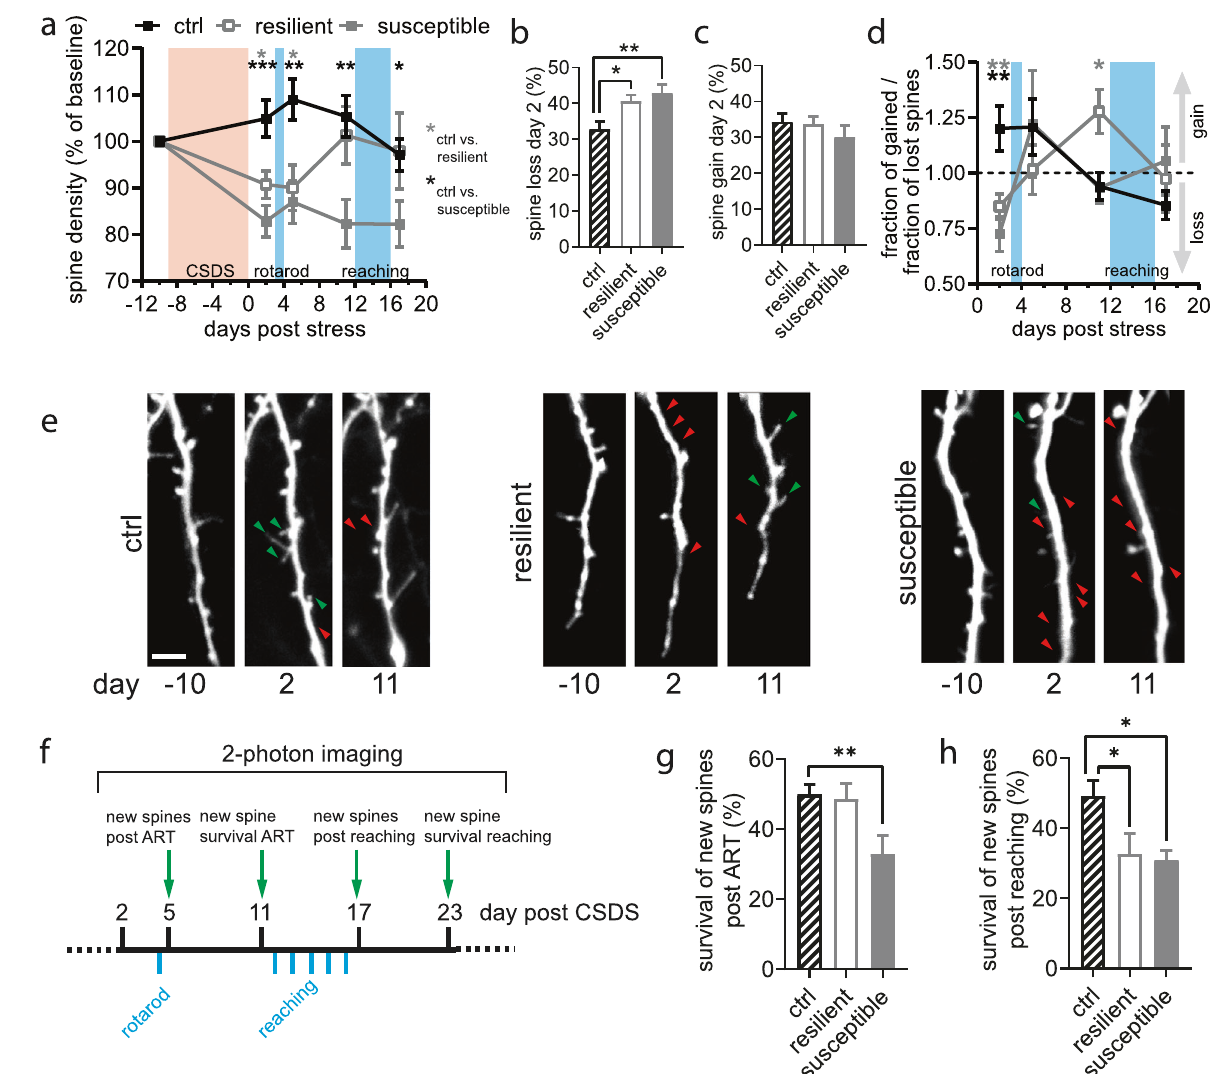
Fig. 3 Response and recovery of motor cortical spine dynamics after CSDS. a Development of spine density from day 2 until 17 post CSDS (time F 3.155,163.3 = 3.425, P = 0.017, stress F 2,64 = 8.324, P = 0.0006, Interaction F 8,207 = 4.211, P = 0.0001, RM ANOVA mixed model with Dunett ’ s post-hoc test). b , c Change in spine loss but not spine gain drives the change in spine density on day 2 (loss: F 2,64 = 6.784, P = 0.002, one-way ANOVA with Dunett ’ s post-hoc test, gain: F 2,64 = 0.767, P = 0.487, one-way ANOVA). d Net gain or loss between imaging sessions is differently in fl uenced by stress over time (time F 2.303,109.8 = 2.221, P ≥ 0.05, stress F 2,51 = 0.347, P ≥ 0.05, interaction F 6,143 = 3.164, P ≤ 0.01, RM ANOVA mixed model). e Example time lapse images of dendritic spines at baseline (day − 10), day 2 and 11 post CSDS (green arrowhead = new spine, red arrowhead = lost spine). Scale bar: 5 µm). f , g Survival fraction of spines formed after the different motor learning tasks (rotarod [ART]: F 2,48 = 4.918, P = 0.011, reaching: F 2,31 = 4.477, P = 0.020, both one-way ANOVA with Dunett ’ s post-hoc test). a – d , g , h : no. of ROIs/mice from day − 10 to 17: ctrl 26/19 to 23/12, resilient 22/10 to 10/5, susceptible 16/10 to 13/8, see also Supplementary Table 1). * P < 0.05, ** P < 0.01, *** P < 0.001. Results are shown as mean ±